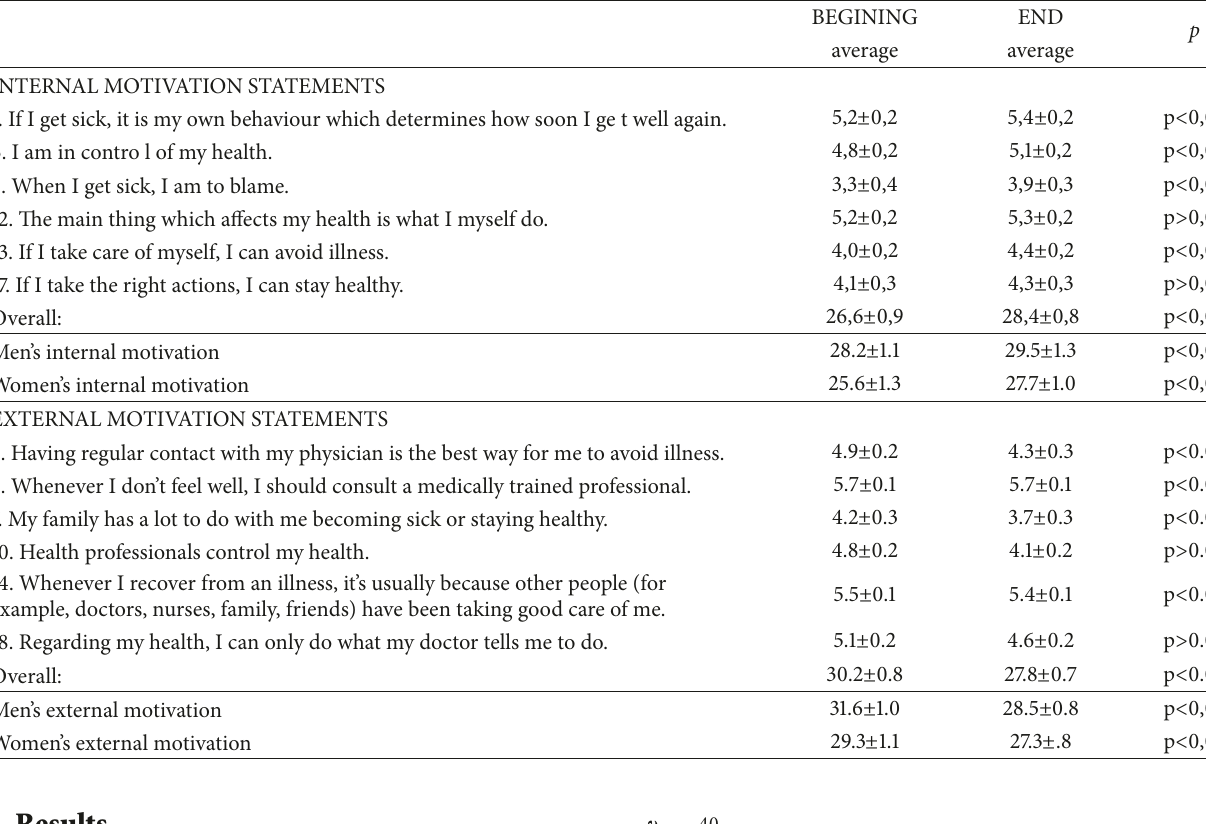
Table 2: The dynamics of internal and external motivation at the beginning and at the end of rehabilitation.